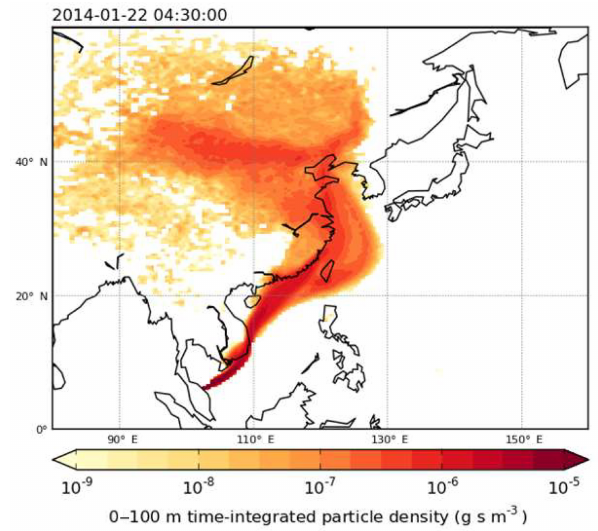
Figure 9. NAME footprint derived from 12-day backward simu- lation and showing the time-integrated density of particles below 100m altitude on 22 January 2014 during a period of elevated CFC- 113a mixing ratios at Bachok,